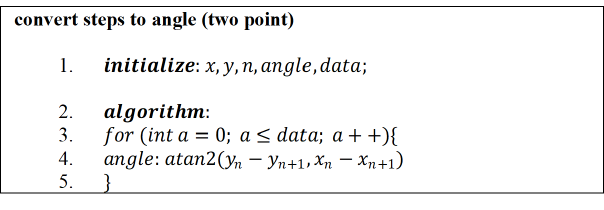
Figure 11. Algorithm for calculating angle from two point.